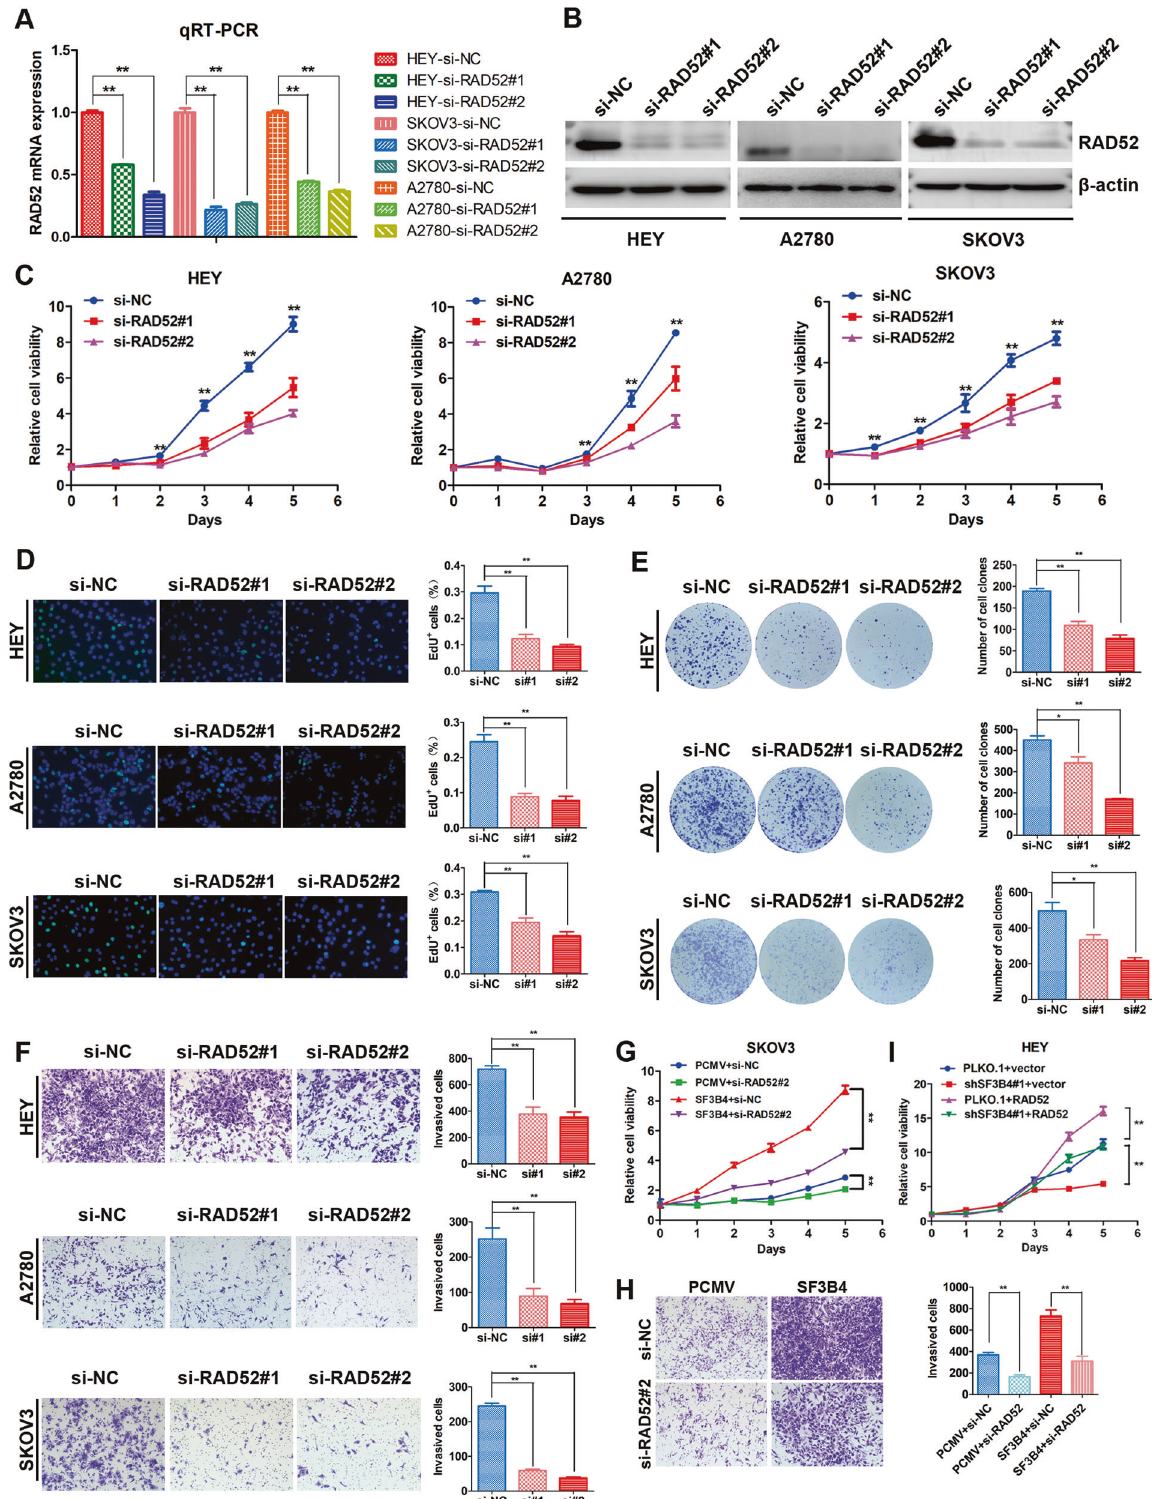
Fig. 6 RAD52 promotes cell proliferation and mobility in ovarian cancer cells. A , B RAD52 knockdown ef fi ciency was con fi rmed by qRT-PCR ( n = 3 biologically independent samples) and western blotting. C Growth curve and ( D ) EdU assay and ( E ) clonogenic assay were used to evaluate the effect of SF3B4 on the proliferation of HEY, A2780, and SKOV3 cells ( n = 3 biologically independent samples). F Transwell assay showed the invasion capacity of ovarian cancer cells upon RAD52 knockdown ( n = 3 biologically independent samples). G , H Different growth and invasion abilities associated with different expression levels of SF3B4 and RAD52 in SKOV3 cells ( n = 3 biologically independent samples). I Growth curve assay was used to investigate the potential of RAD52 to rescue the loss of SF3B4 in ovarian cancer cells ( n = 3 biologically independent samples). P -value was obtained by Unpaired t -test. * P < 0.05, ** P < 0.01.